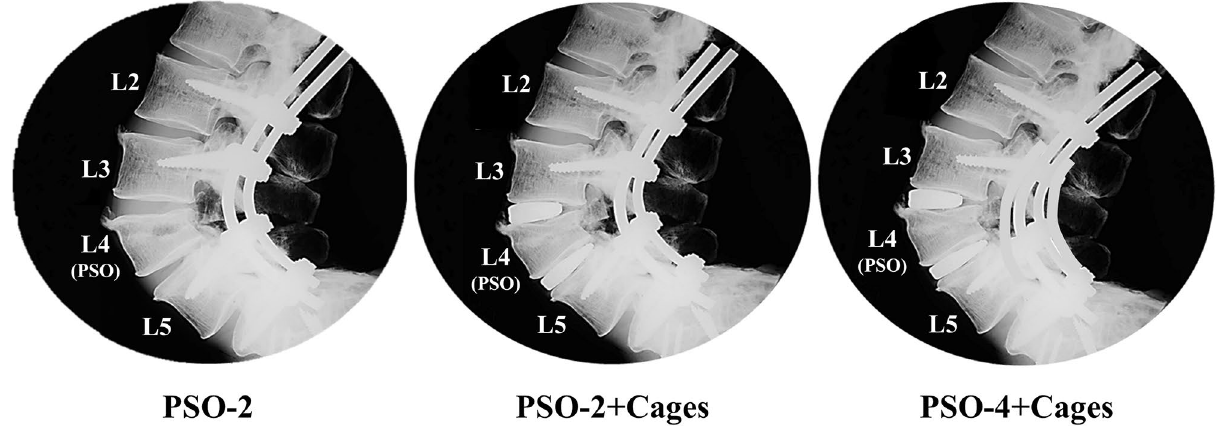
Figure 1. Sagittal X-ray scans of a representative specimen reporting the three steps of